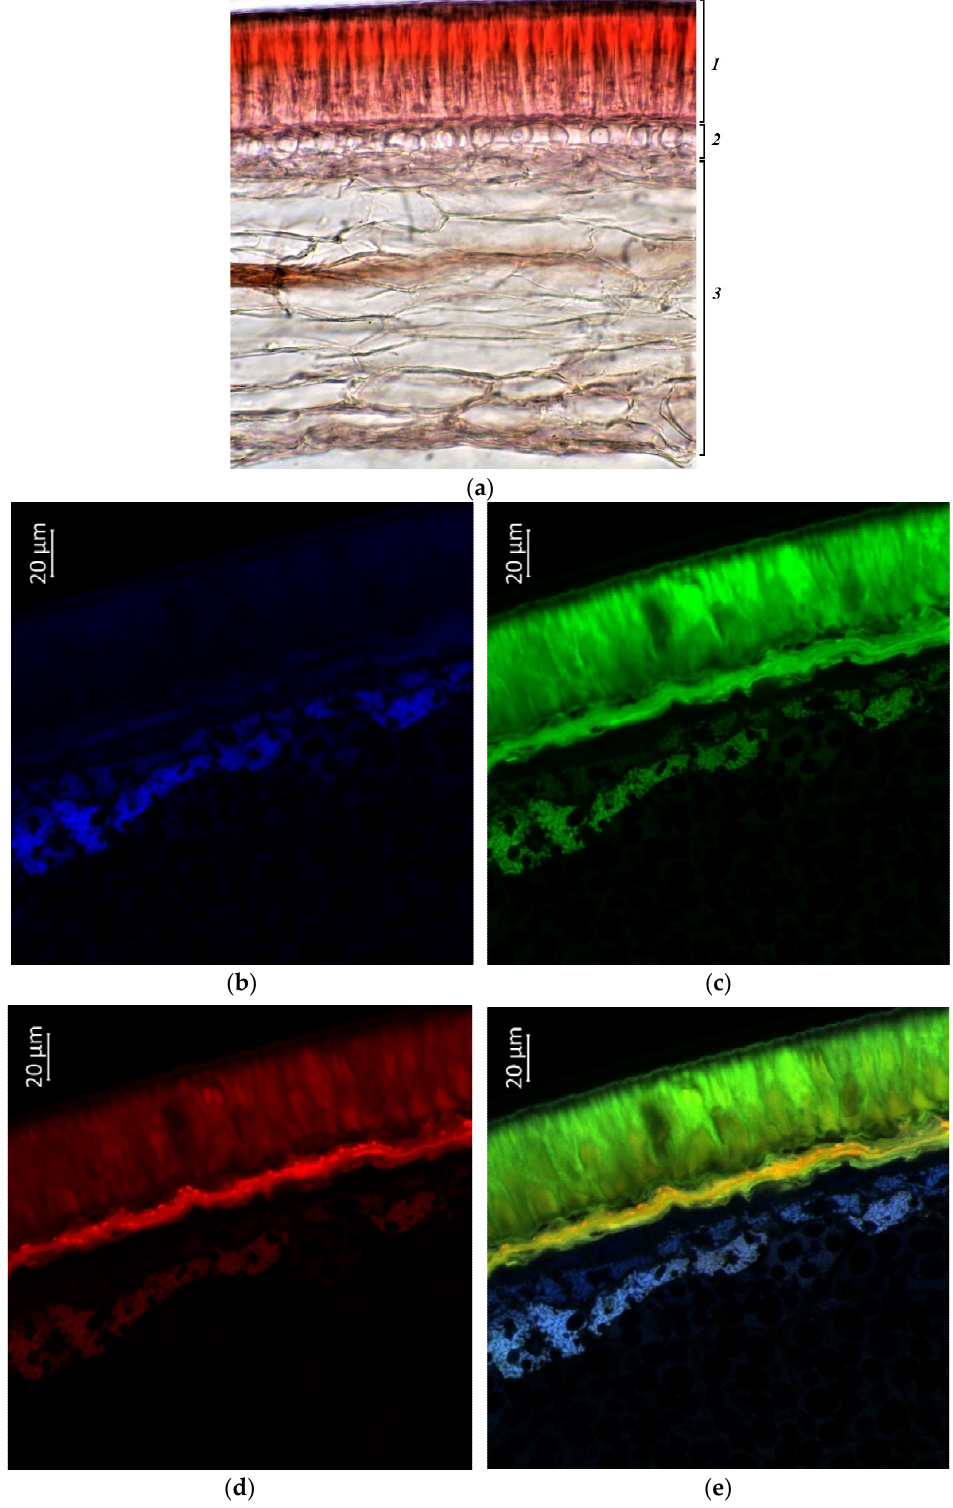
Figure 10. V. unguiculata accession k-640: ( a )—seed coat structure, light microscopy (1—palisade layer, 2—hypoderma, 3—parenchyma); ( b – e )—transverse section of the seed, confocal microscopy, ( b )—excitation 405 nm with the emission in 400–475 nm (blue), ( c )—excitation 488 nm with the emission in 500–545 nm (green), ( d )—excitation 488 nm with the emission in 620–700 nm (red), ( e )— merged.